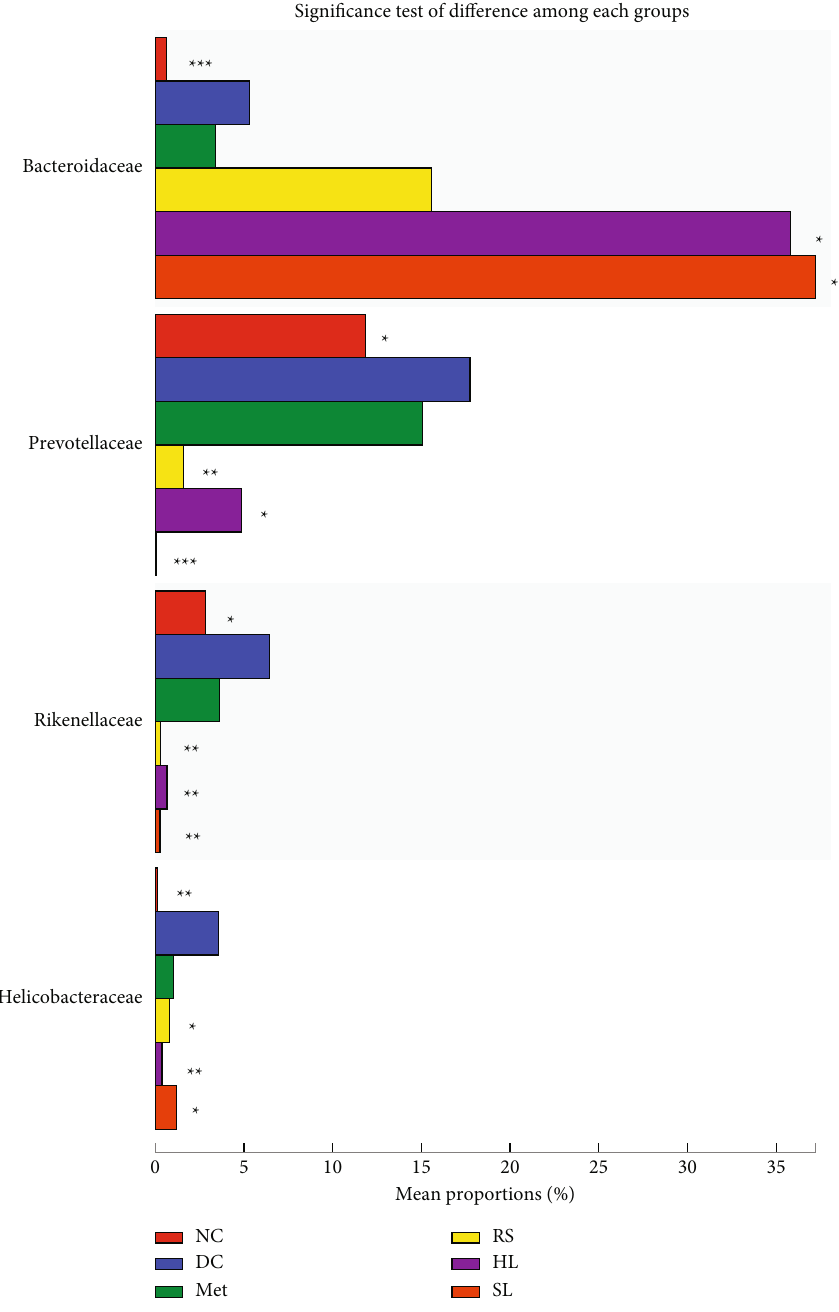
Figure 8: Signi fi cance test of di ff erence of Bacteroidaceae, Prevotellaceae, Rikenellaceae, and Helicobacteraceae among each group, ∗ P < 0 : 05 ; ∗∗ P < 0 : 01 ; ∗∗∗ P < 0 : 001 , compared with the DC